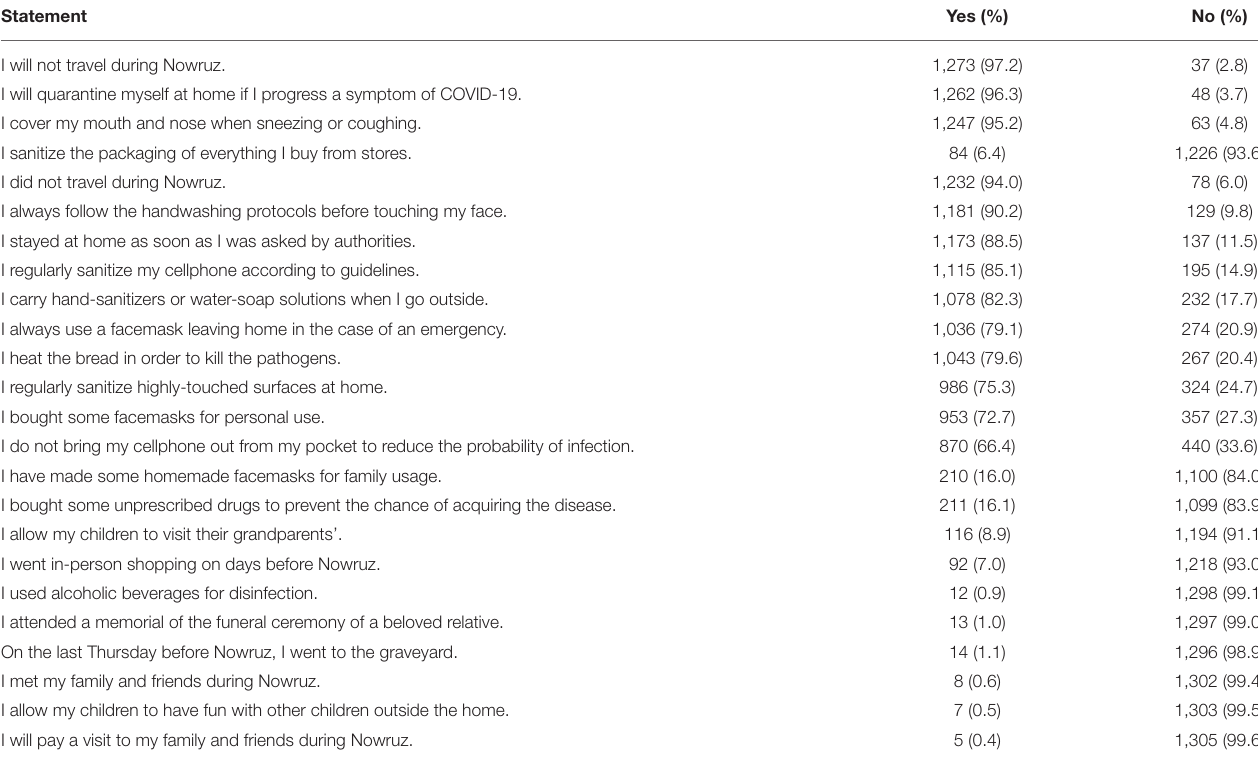
TABLE 8 | General statements regarding practices of participants about